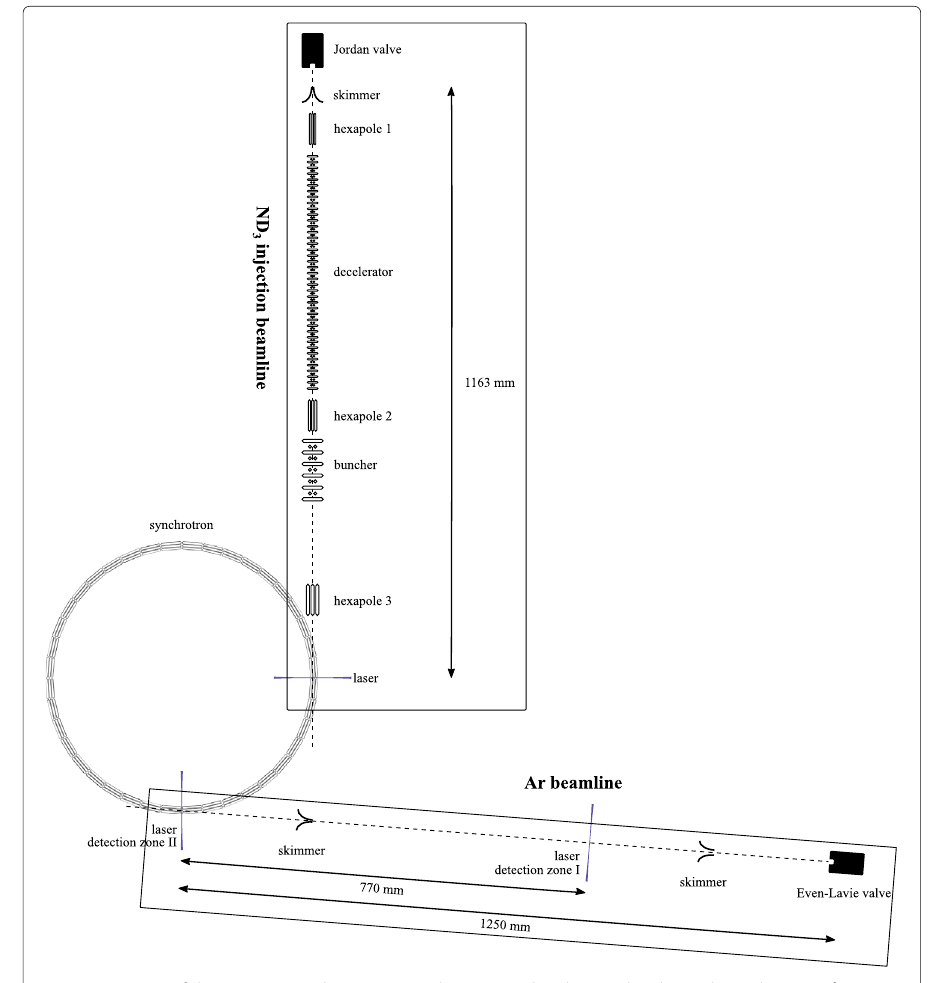
Fig. 3 Top view of the experimental set-up (to scale). ND 3 molecules are decelerated to velocities of 100–150 m/s using a Stark decelerator and injected into a molecular synchrotron consisting of 40 electric hexapole elements arranged in a half-meter-diameter circle. Ammonia molecules can be detected at the injection point or at a quarter ring downstream (detection zone II). The argon beamline consists of a cooled solenoid valve that is skimmed by a 5 mm and a 1.5 mm skimmer. Argon atoms are detected 770 mm in front of the synchrotron (detection zone I) or inside the synchrotron (detection zone II). The argon beamline makes an angle of 94,5 degrees with respect to the injection beamline such that the argon beam moves parallel to the first hexapole in the synchrotron behind detection zone